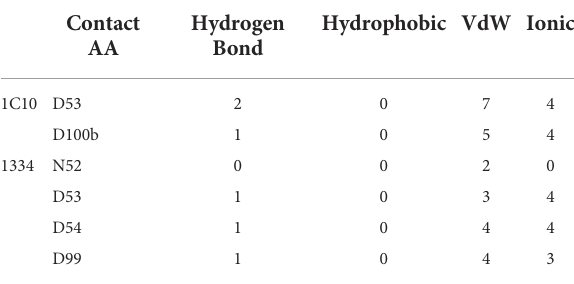
TABLE 1 Contact residues of interface between R315 and 1C10 or